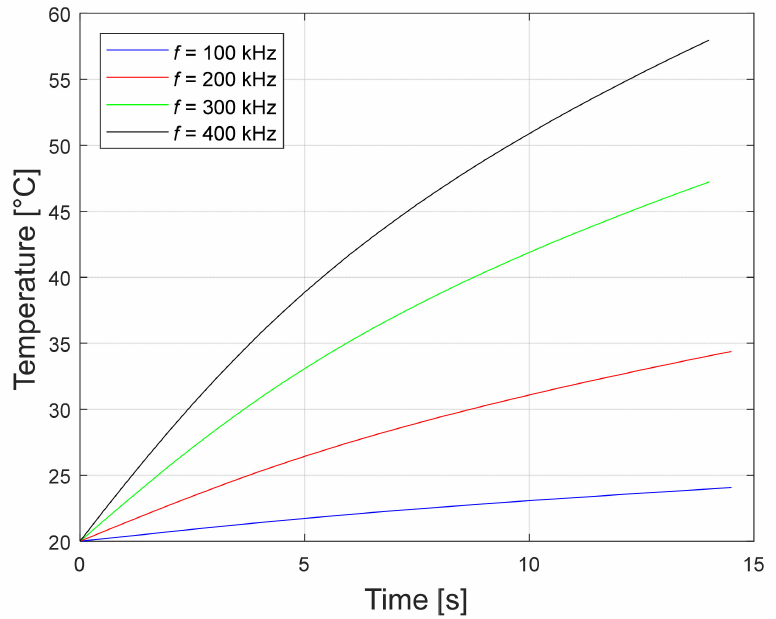
Figure 21. Calculated time–temperature curves at different frequencies with magnetic field strength amplitude being H = 7.83